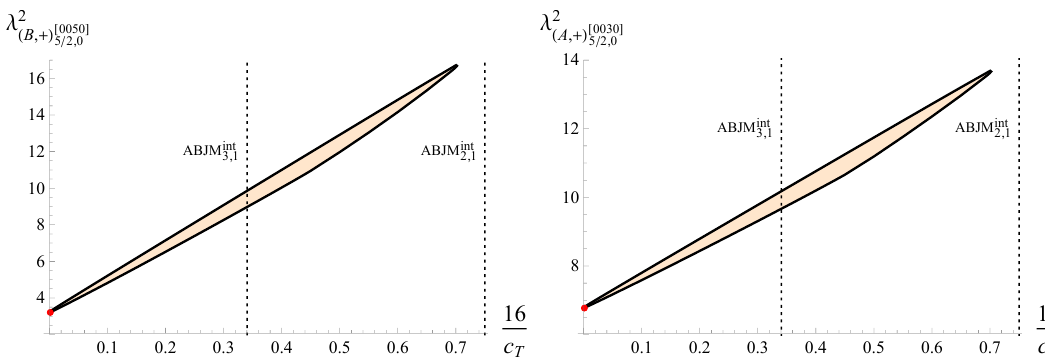
Figure 3 . Upper and lower bounds on (cid:21) 2 where the orange shaded regions are allowed. These bounds are computed using mixed correlators with (cid:3) = 35, the 1d crossing relations imposed, and the OPE coe(cid:14)cient of the free multiplet set to zero. The red dot corresponds to the known GFFT values in table 4. The black dotted vertical lines correspond to ABJM int